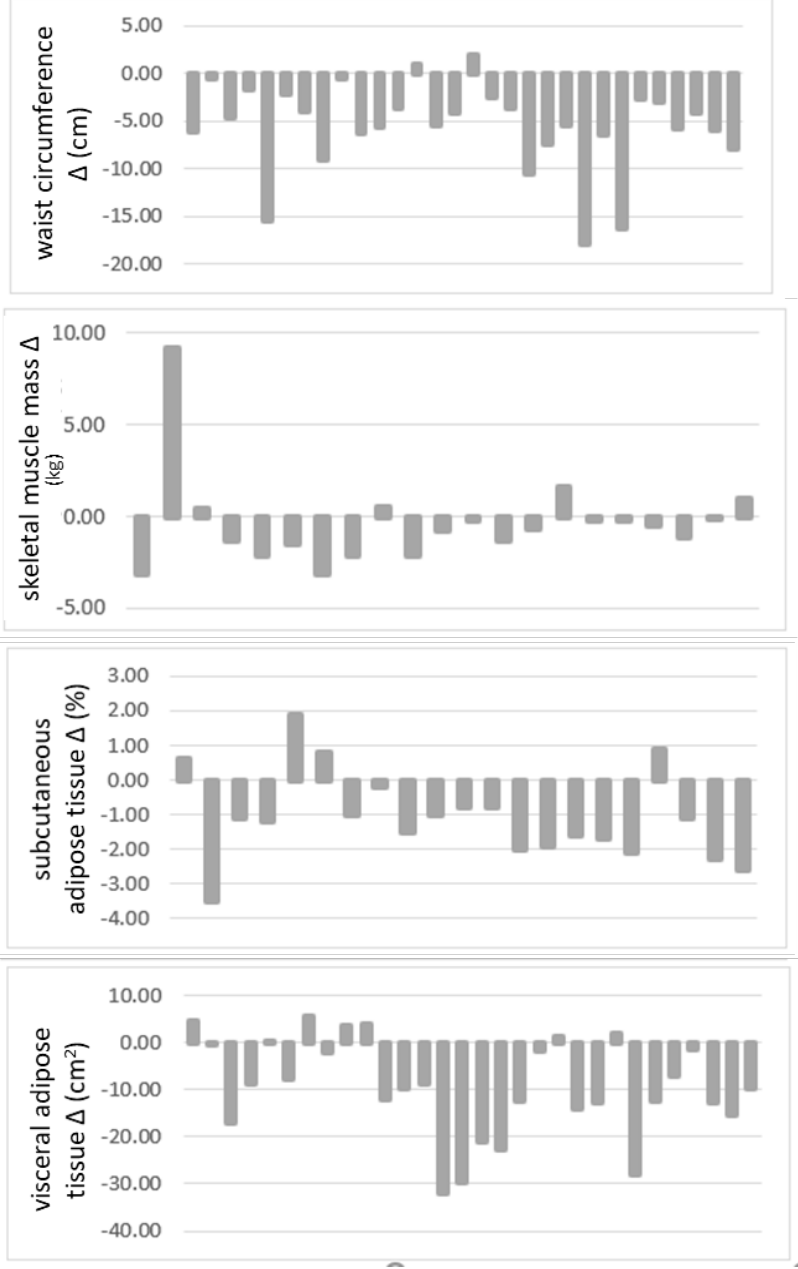
Figure 3. Changes in anthropometric and body composition measurements after the